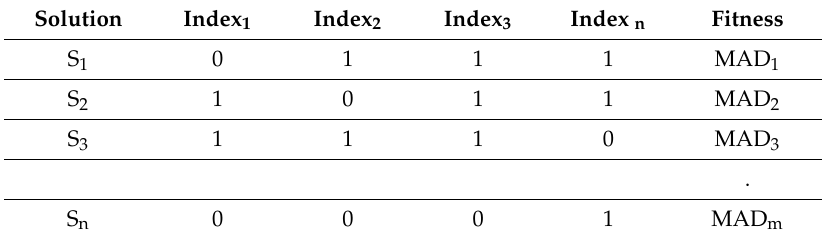
Table 2. Initial population of features; each row (Si) is a solution, and each column is a